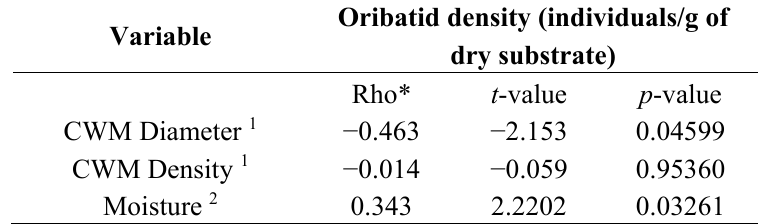
Table 3. Pearson-product moment correlations between adult oribatid density (log transformed) and environmental variables measured in individual soil cores.